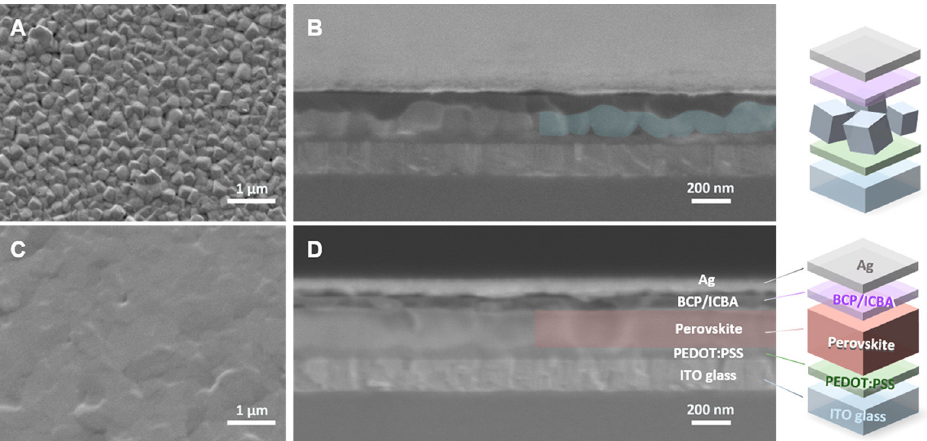
Figure 21. Pristine Sn-PVK ( A ) surface morphology, ( B ) cross-section, Trimethyl urea assisted Sn-PVK ( C ) surface morphology, ( D ) cross-section. Reprinted with permission [51]. Copyright 2022, American Chemical Society.